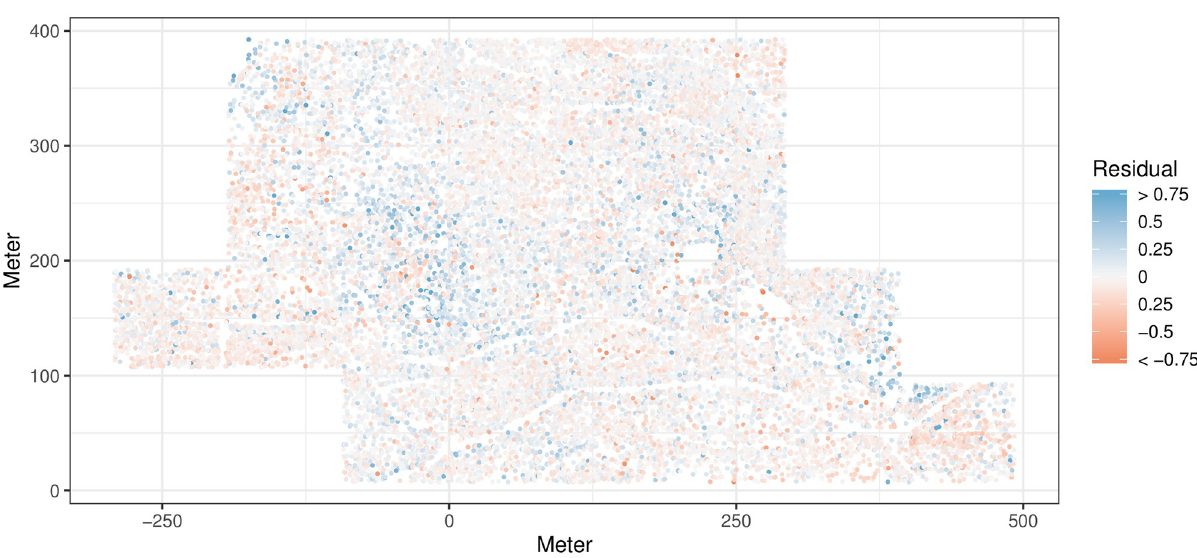
Fig 6. Spatial pattern of residuals for the family-level model. This shows the actual growth y of each tree minus its predicted growth ^ y ^ . Blue individuals grew faster than expected by the model and red individuals grew slower. The residuals show clear spatial